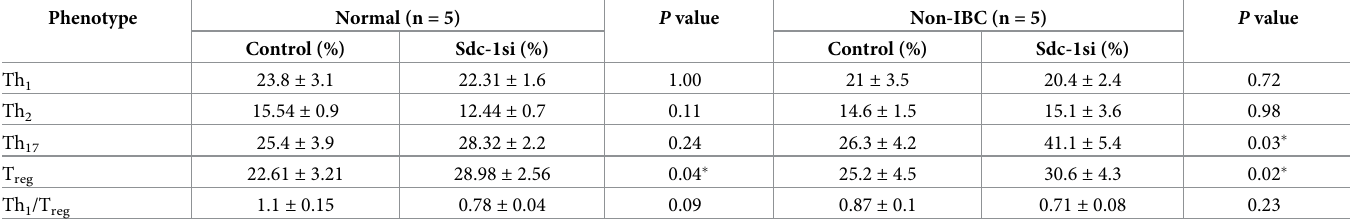
Table 4. Summary of CD4 + T helper subsets of normal subjects and non-IBC patients upon direct co-culture with control and Sdc-1-silenced SUM-149 cells.